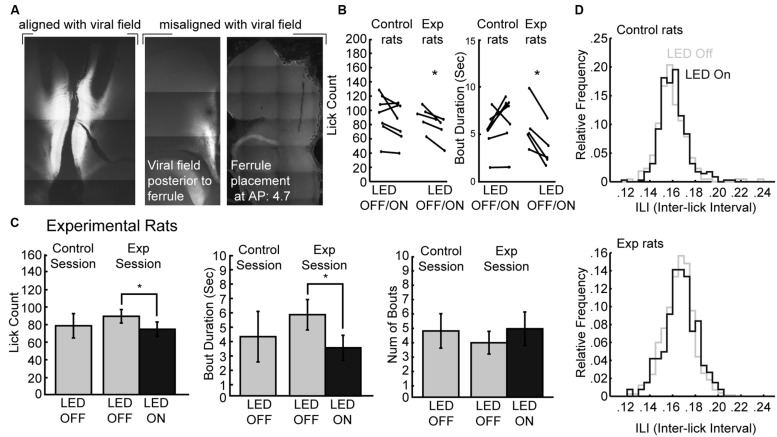
Optogenetic perturbation of the rostral mPFC prevents persistent licking. (A) Fluorescent GFP expression driven by the non-specific CAG promoter showed evidence for transduction of archaerhodopsin (ArchT) in the rostral mPFC of experimental rats. Control rats either did not show proper alignment of viral field with implanted ferrules or showed no viral expression. (B) Transient perturbation of the rostral mPFC in experimental rats via LED activation consistently decreased licking and bout duration. There was no consistent change in licking by LED in control rats. (C) Transient perturbation of the rostral mPFC in experimental rats via LED activation consistently decreased licking in epochs with LED on relative to epochs with LED off. The optogenetic perturbation of rostral mPFC in experimental rats also reduced the duration of licking bouts. There was no significant change in the number of bouts initiated with the LED activated. (D) The ability to lick within bouts was not affected as there was no significant change in the ILI histogram of licking during epochs between epochs with the LED on and the LED off. *p < 0.05.